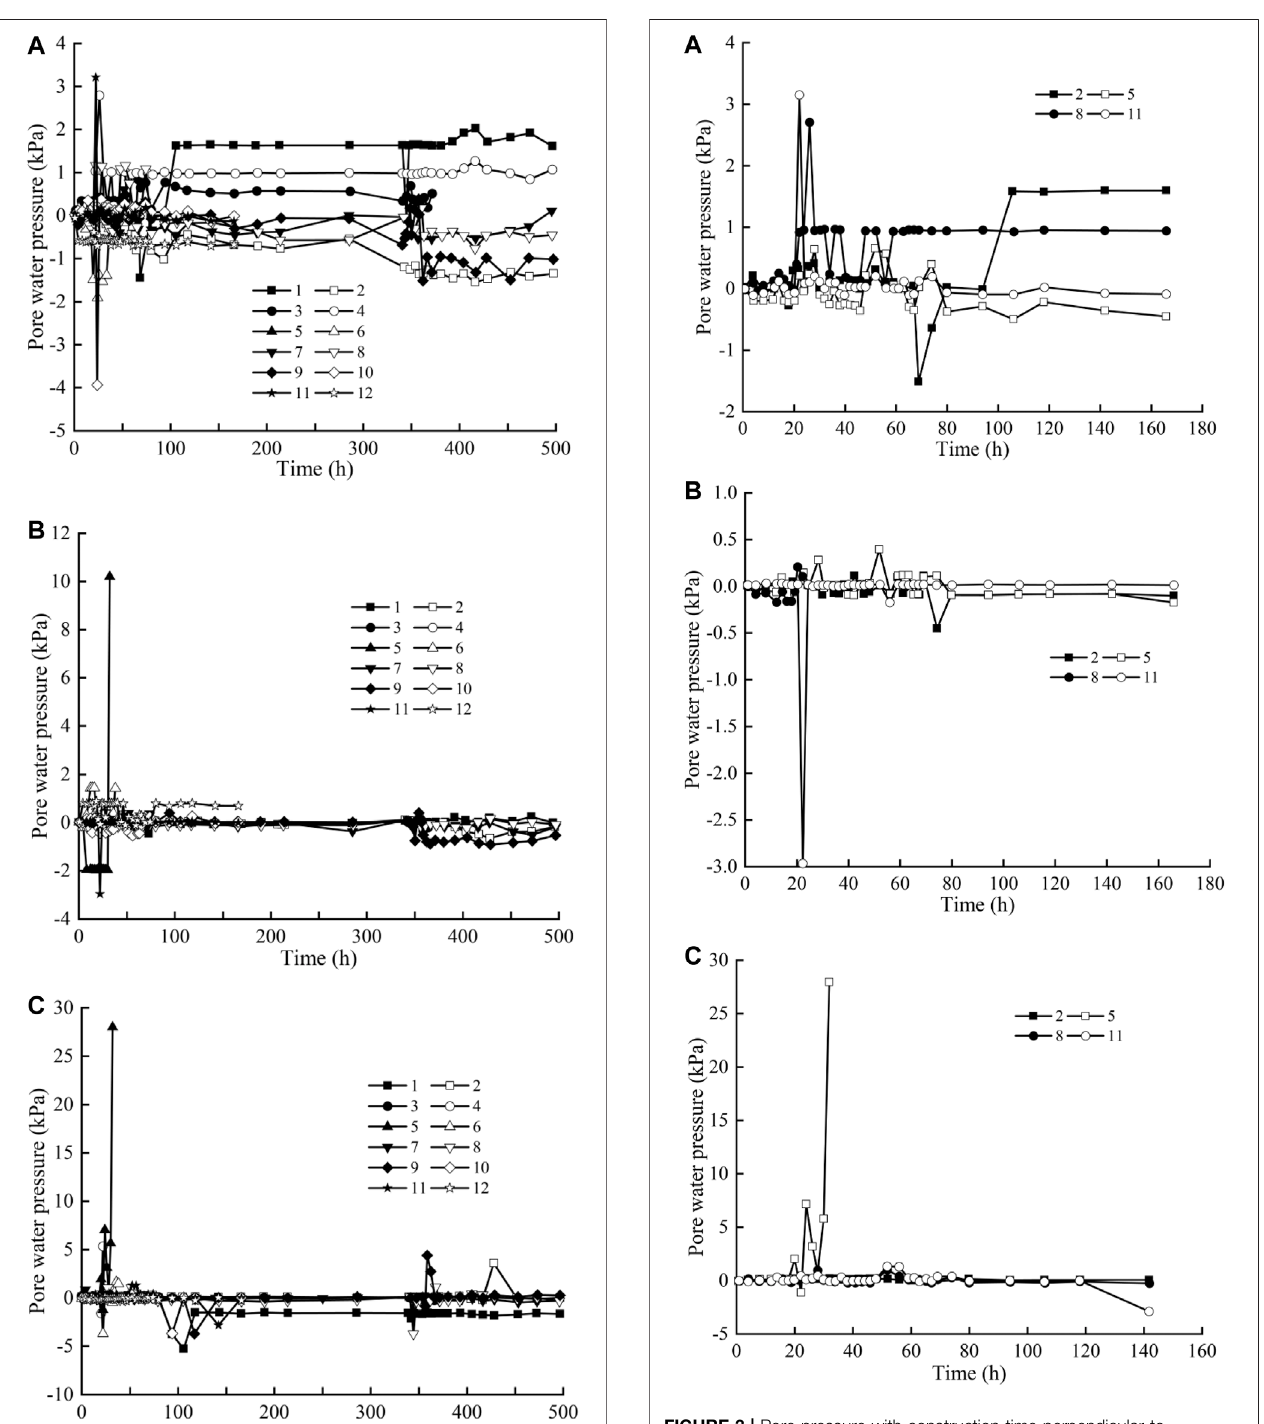
Frontiers in Earth Science |